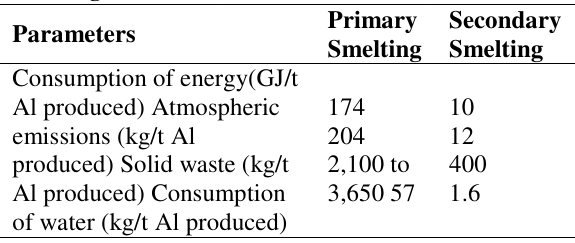
Table1, Comparison of Primary and Secondary Aluminum Smelting Processes (data from Gil 2005) .